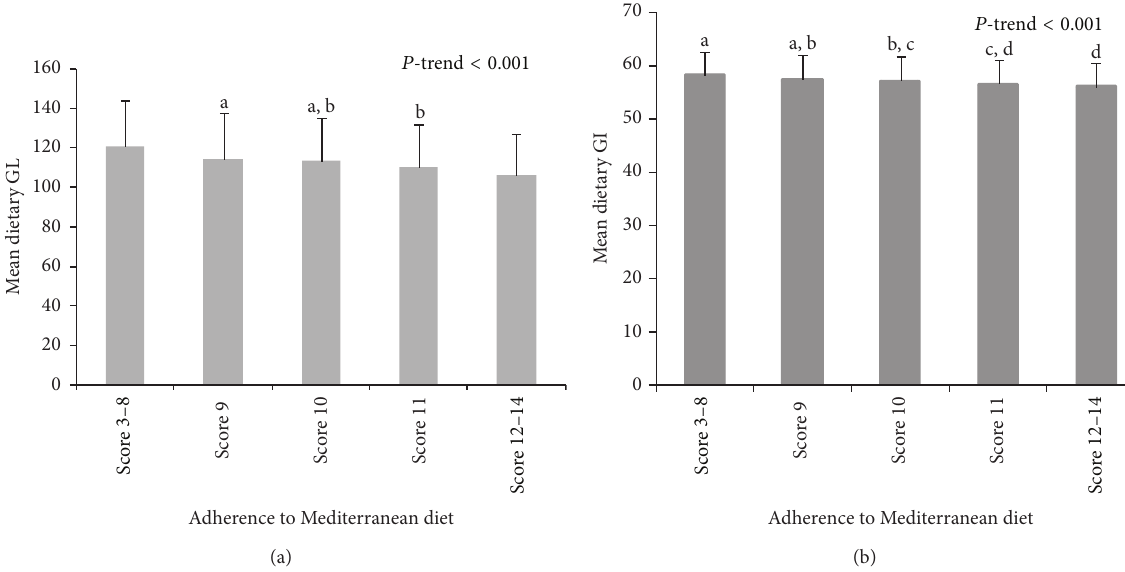
Figure 2: Mean dietary GL and GI quintiles according to the adherence to Mediterranean diet in the PREDIMED study at one year of follow-up. Means with superscripts without a common letter differ, 𝑃 < 0.05 .